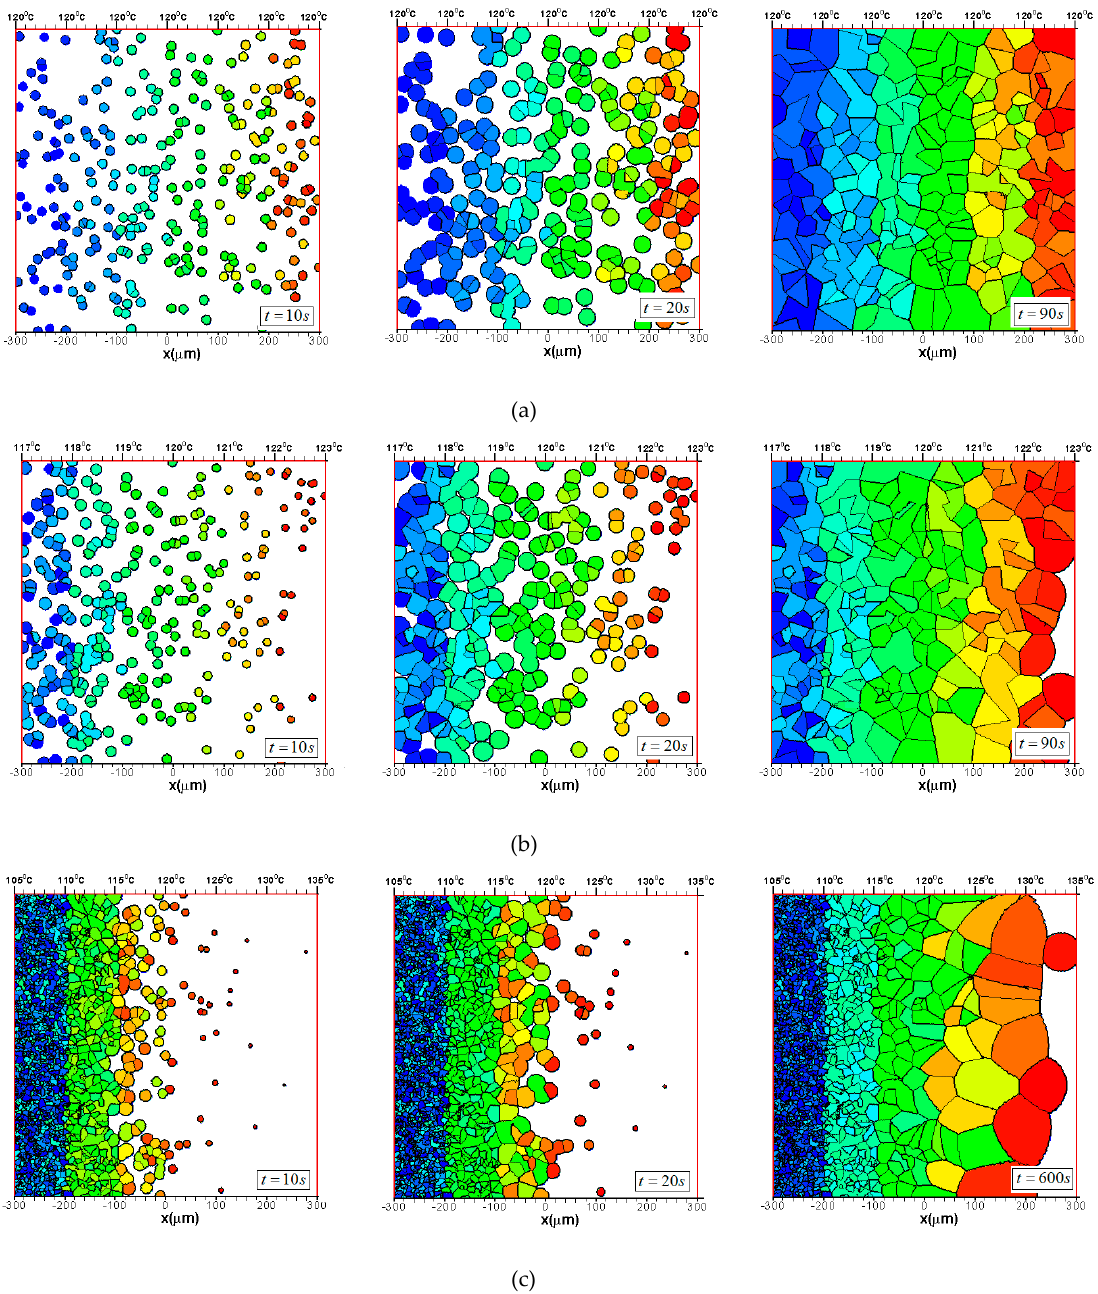
Figure 8. Morphology evolution with the central temperature T 0 = 120 ◦ C: ( a ) isothermal ( Λ = 0 K/mm), ( b ) Λ = 10 K/mm, ( c ) Λ = 50 .